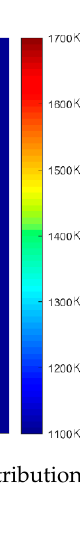
Figure 7. Temperature distributions with effective measurement areas.